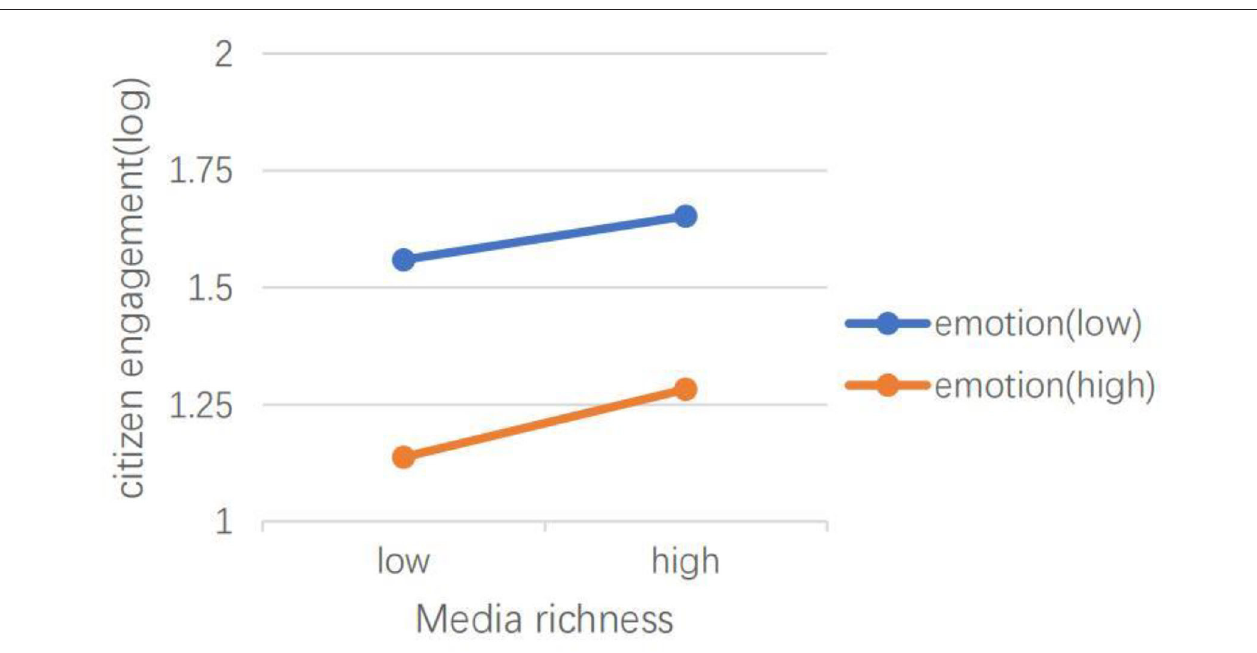
FIGURE 8 | Two-way interaction between media richness and emotional valence in predicting CEGSM in the case drop stage.